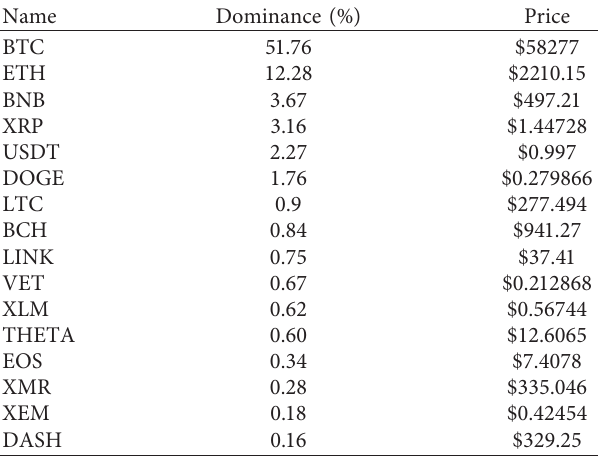
Table 2: The dominance of 16 cryptocurrencies.